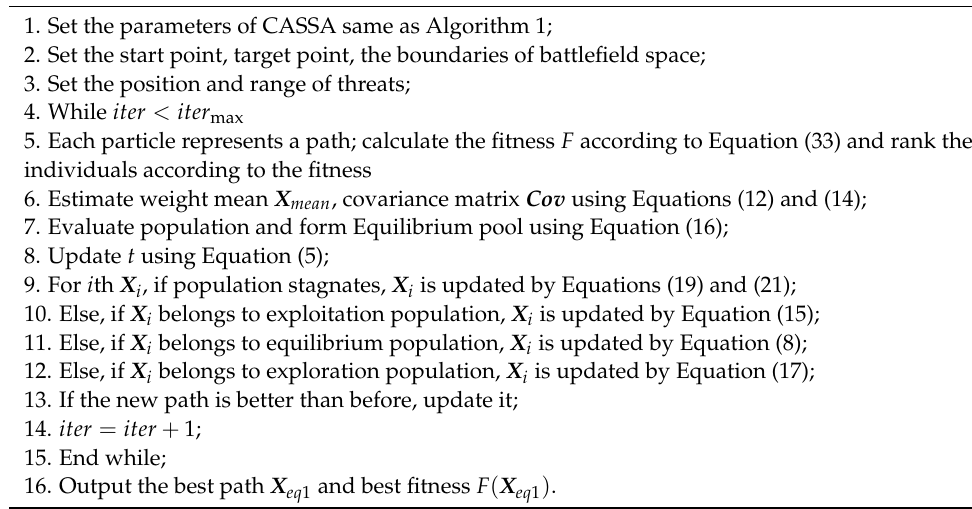
Algorithm 2. MHEO for unmanned aerial vehicle (UAV) path planning